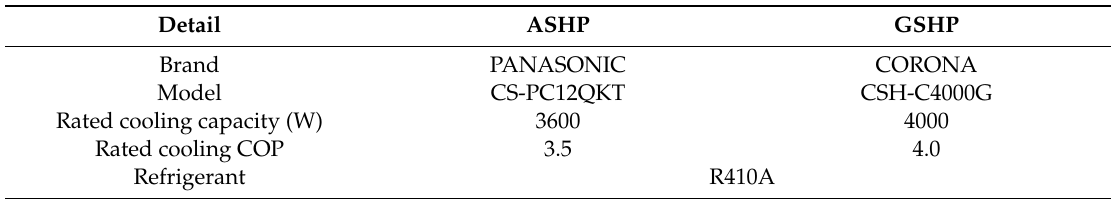
Table 1. The specification of the ASHP and GSHP.